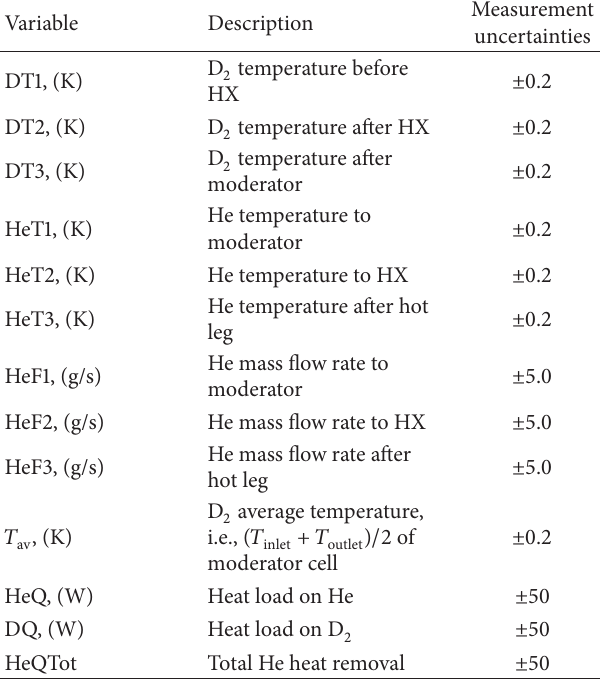
Table 1: Experimental parameters for the PNPI